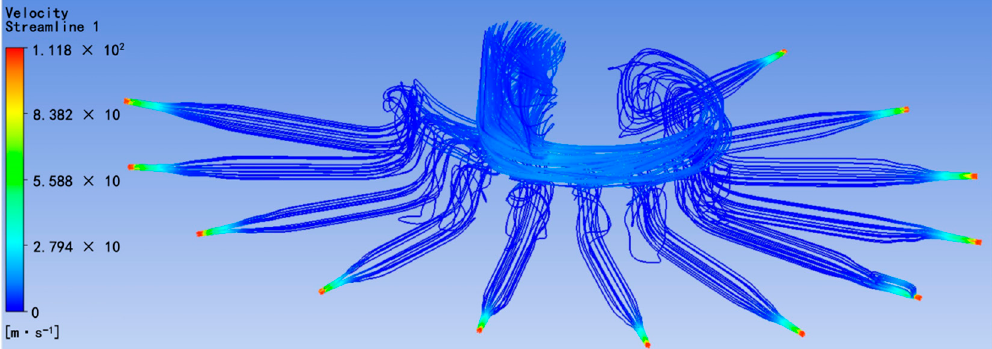
Figure 9. Streamline diagram of fluid domain.